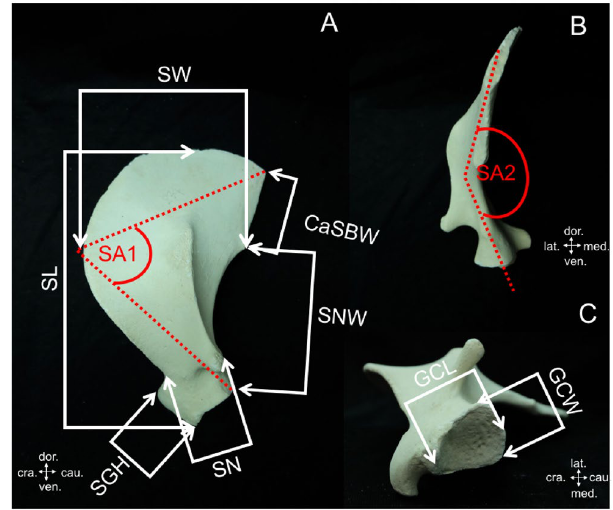
Figure 3. Landmarks for measurements taken from the dugong scapula (see description of measurements in Table 3). (cra. = cranial, cau. = caudal, dor. = dorsal, lat. = lateral, med. = median, ven. =